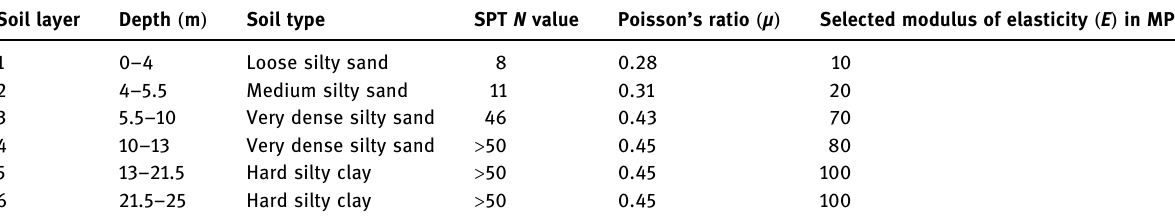
Table 1: Poisson ’ s ratio ( µ ) and modulus of elasticity ( E ) for the soil pro fi les in Al - Kufa Mosque Soil layer Depth ( m ) Soil